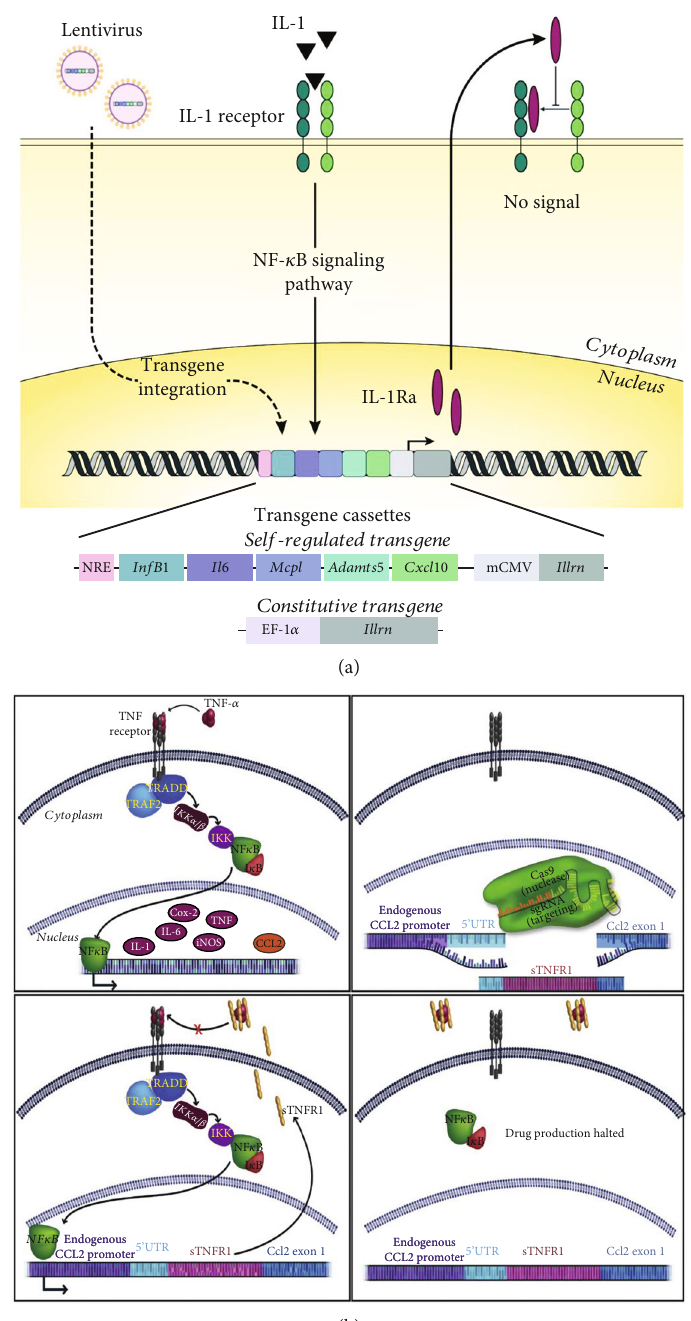
Figure 5: Synthetic gene circuits for self-regulated drug delivery systems. (a) IL-1 induced IL-1Ra expression through the NF- κ B signaling pathway. (b) sTNFR1 inserted in CCL2 loci can be initiated by TNF and inhibit TNF in return. Reproduced with permission [67,